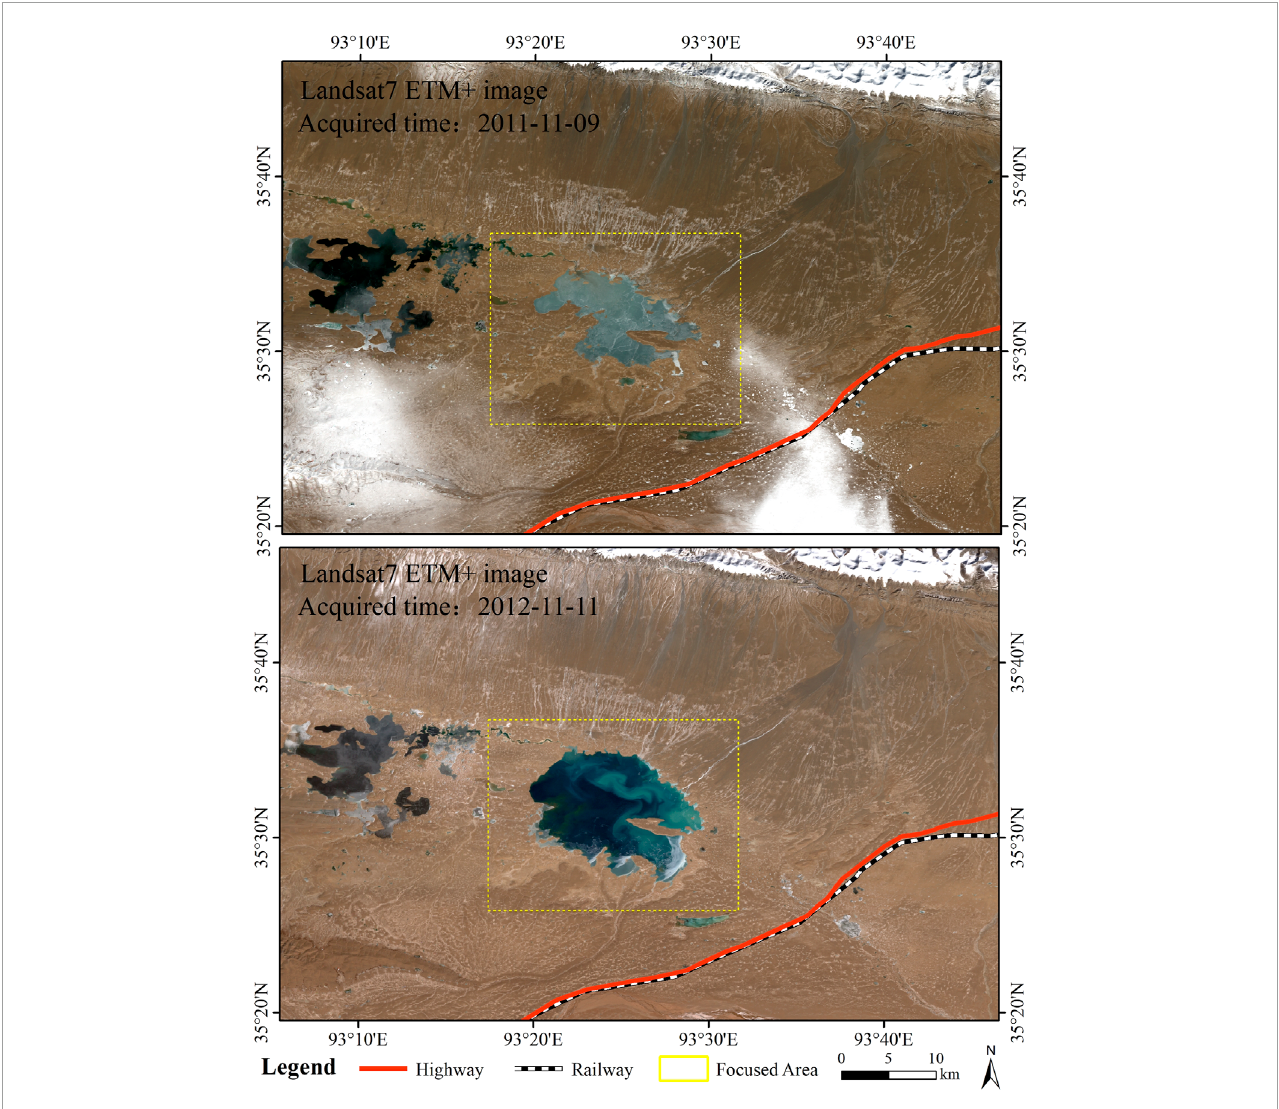
FIGURE 2 The variation of the Salt Lake (yellow box) as observed via the Landsat 7